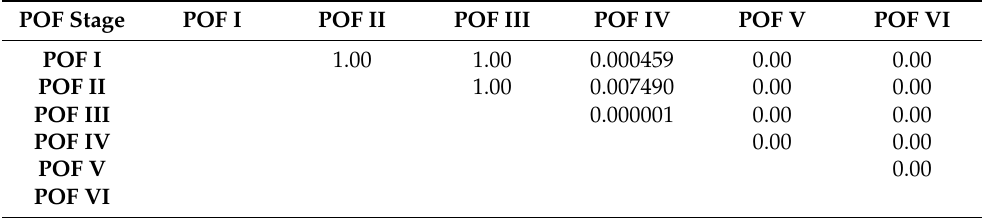
Table 3. Evaluation of difference in mean size of postovulatory follicles (POF) stage. Signifi- cance of differences has been evaluated for each stage (POF I to POF VI) by Kruskal–Wallis test: H (5, n = 1940) = 1056.59 p <